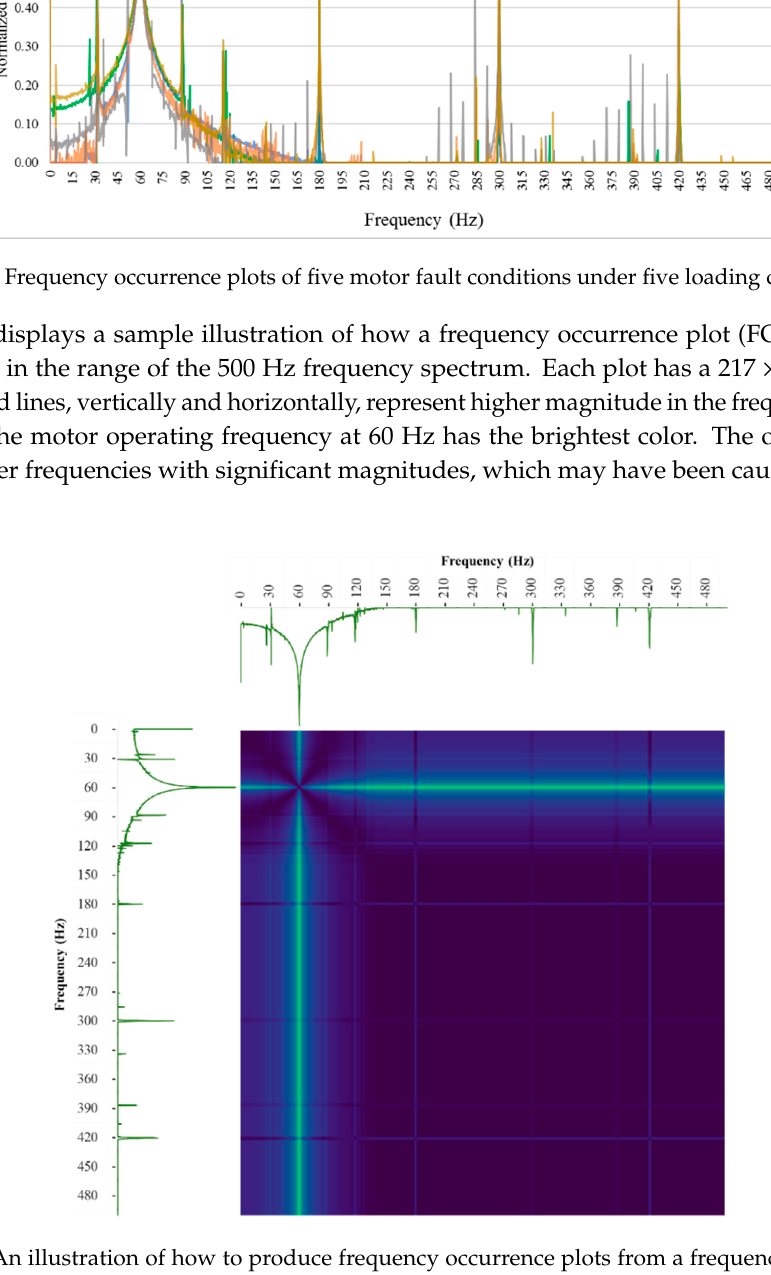
Figure 6. An illustration of how to produce frequency occurrence plots from a frequency spectrum with 500 Hz range.